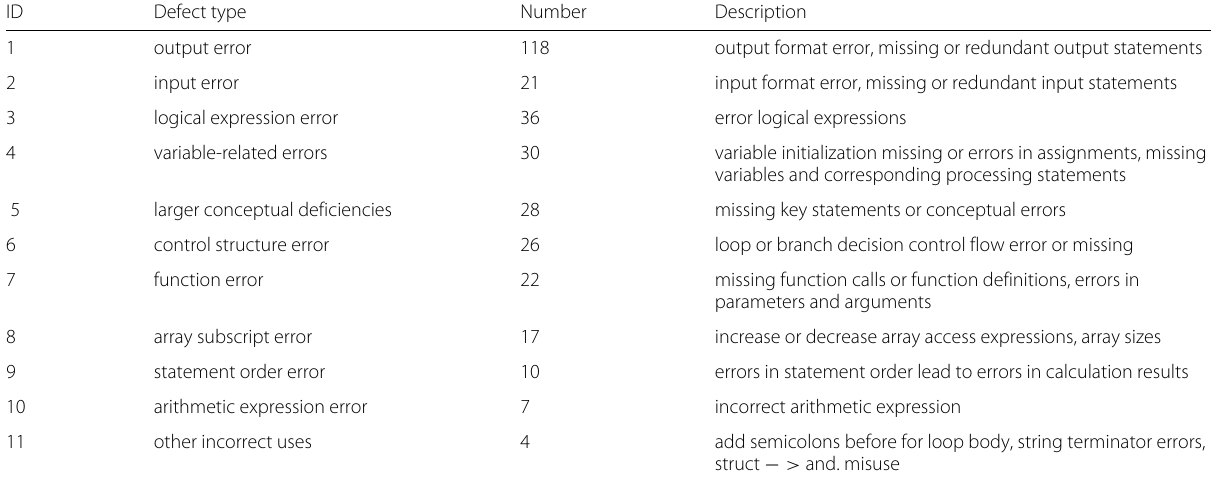
Table 2 Types of bugs which cause programs failed on all the given test cases in the test suite